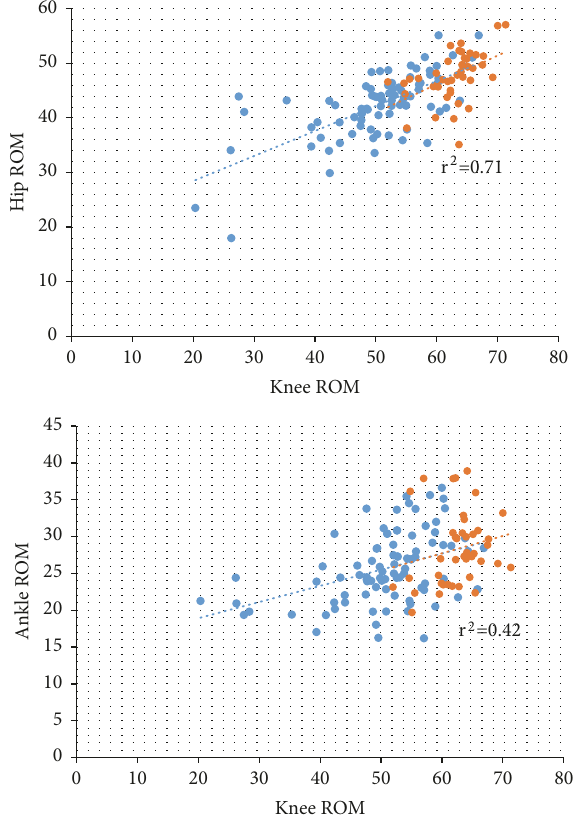
Figure 2: Correlation between knee ROM and hip and ankle ROM. Strong correlations were observed between knee ROM and the hip and ankle ROM. Blue dots indicate the knee OA group. Orange dots indicate the control group. Dotted lines indicate the trend lines. r 2 : Pearson correlation coefficient.